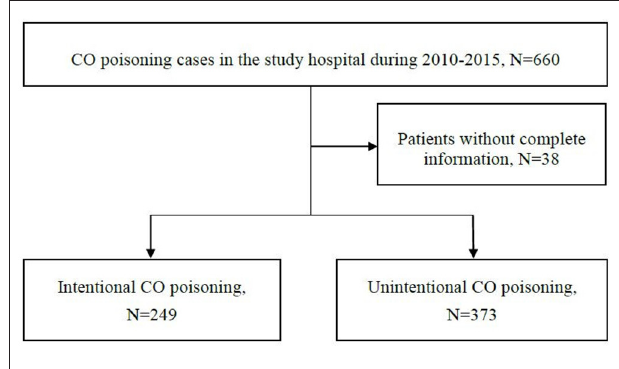
FIGURE 1 | Study flow chart.